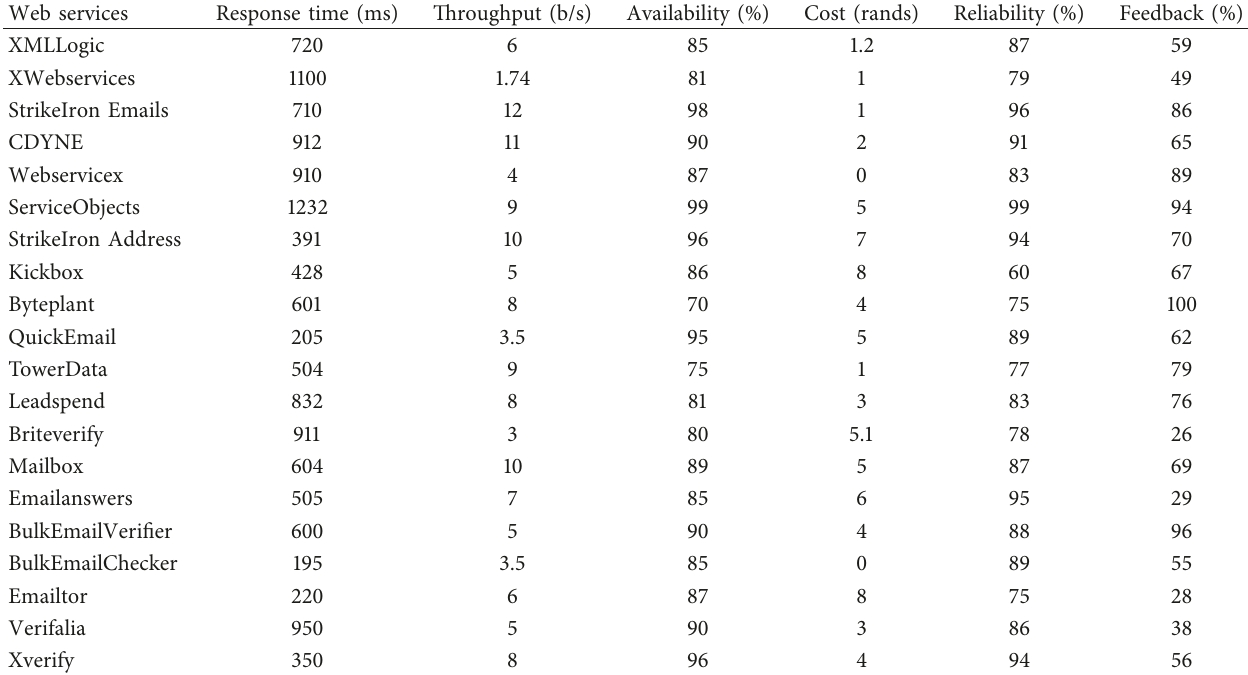
Table 4: QoS metrics for various available e-mail verification web services. Web